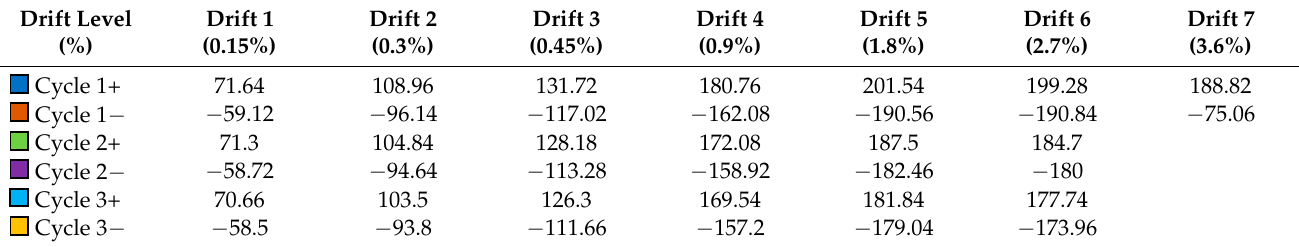
Figure 13. Load-drift diagram of the rectangular pier (for colour legend refer to Table 3).